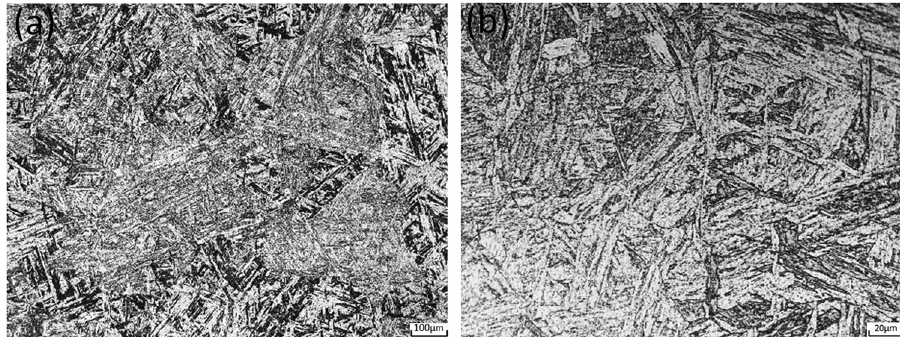
Figure 1: Microstructure of 08Cr9W3Co3VNbCuBN steel. ( a ) 100X, ( b ) 500X.